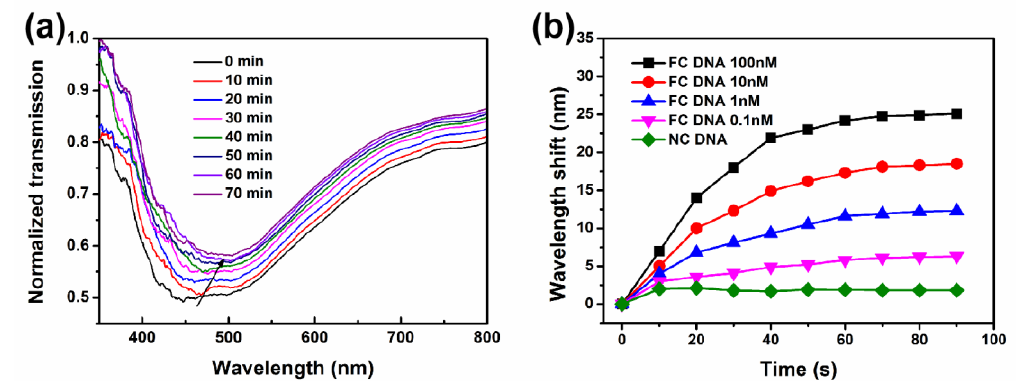
Figure 10. ( a ) The transmission spectra of 100 nM double-stranded DNA hybridization. ( b ) Wavelength drift of NC-DNA and different concentration of FC-DNA (0.1–100 nM) over time.